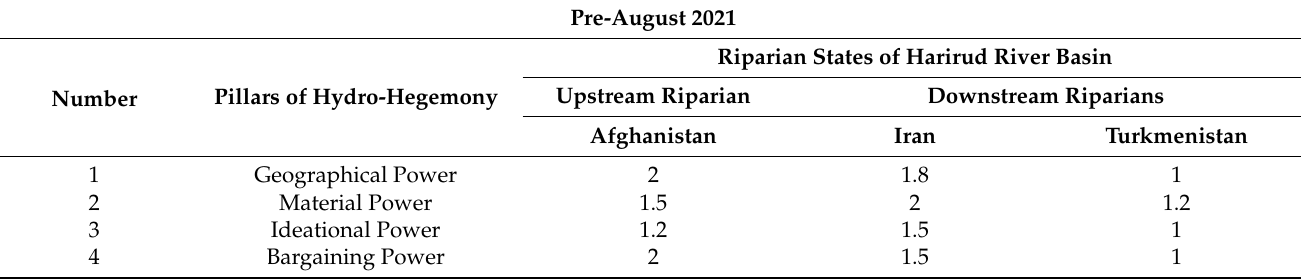
Table 1. The fluctuation of power in each pillar of hydro-hegemony before Taliban’s taking over.